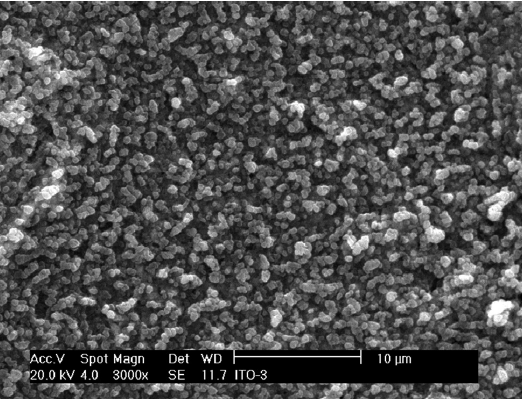
Figure 4. SEM image of the synthesized ITO film.